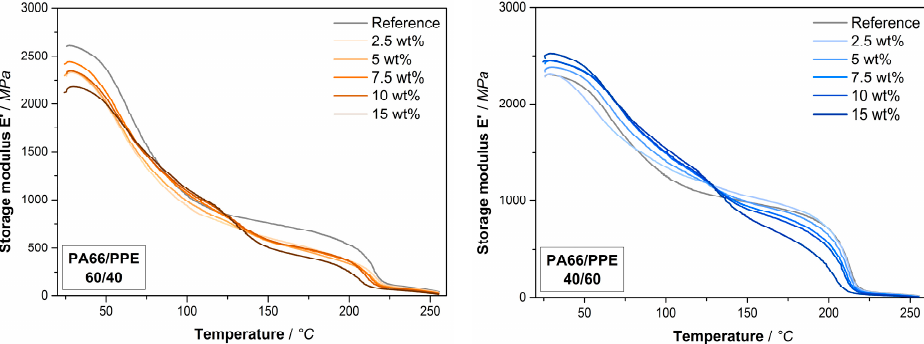
Figure A2. Storage modulus data of the PA66 / PPE / SMA ternary blends with 60 / 40 blend ratio ( left ) and 40 / 60 blend ratio ( right ) at various SMA contents.